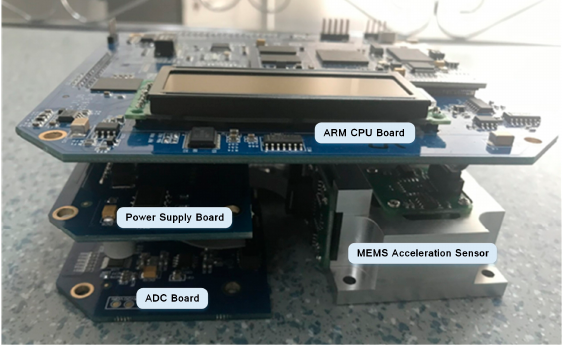
Figure 1. Hardware components of GL-P2B.